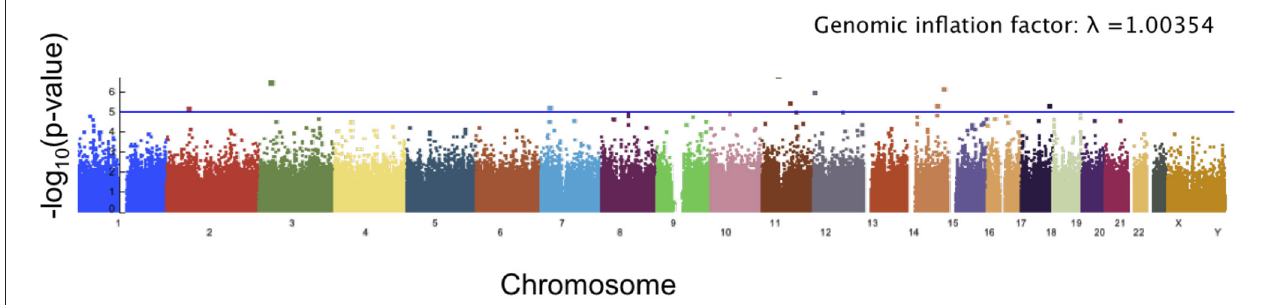
FIGURE 8 | Manhattan plot showing significance of the relationship between each SNP and our angle of deformation scores. The blue line corresponds to a threshold of suggested significance p = 1 × 10 − 5